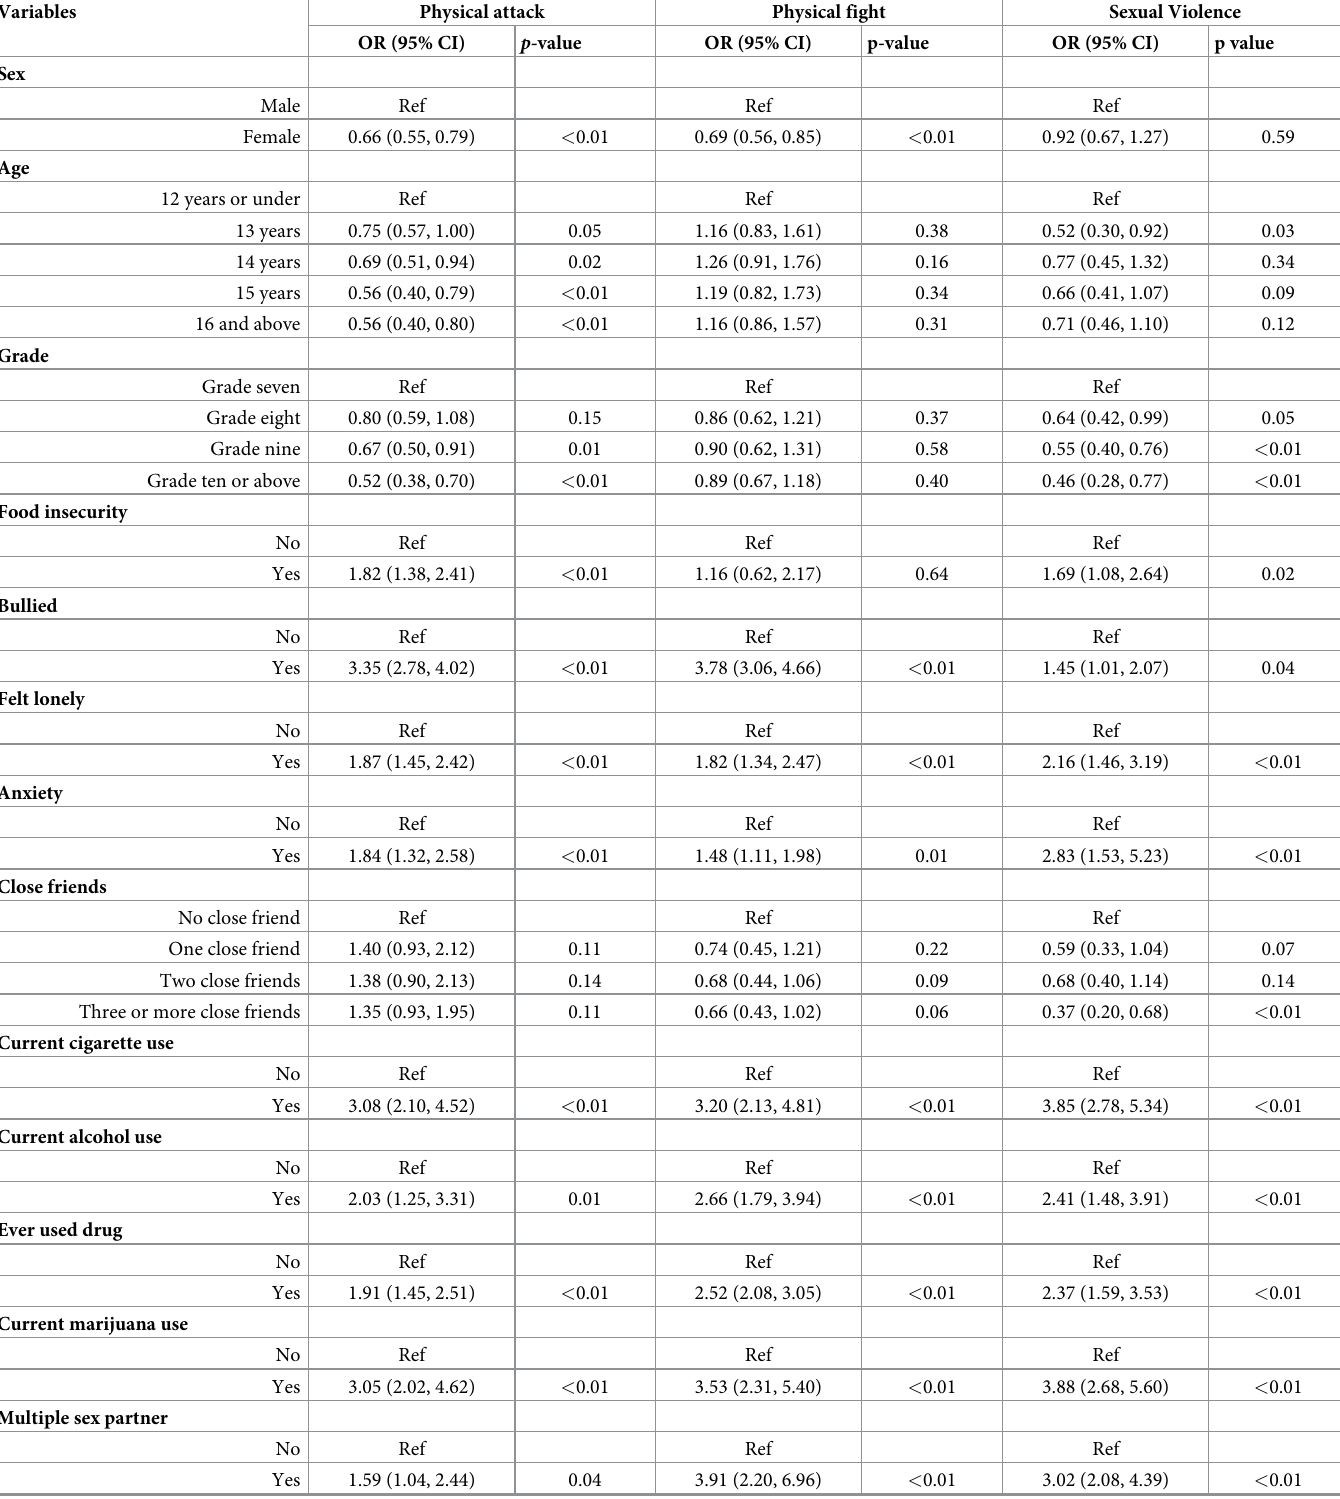
Table 3. Factors associated with physical attack, physical fight, and sexual violence in bivariate analysis.